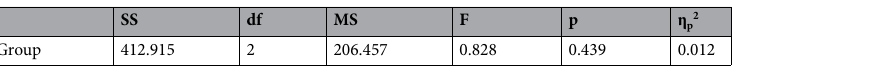
Table 5. Results of one-way ANOVA on the absolute differences of arm spread metric data between different age groups (pre-kindergarteners, schoolers,